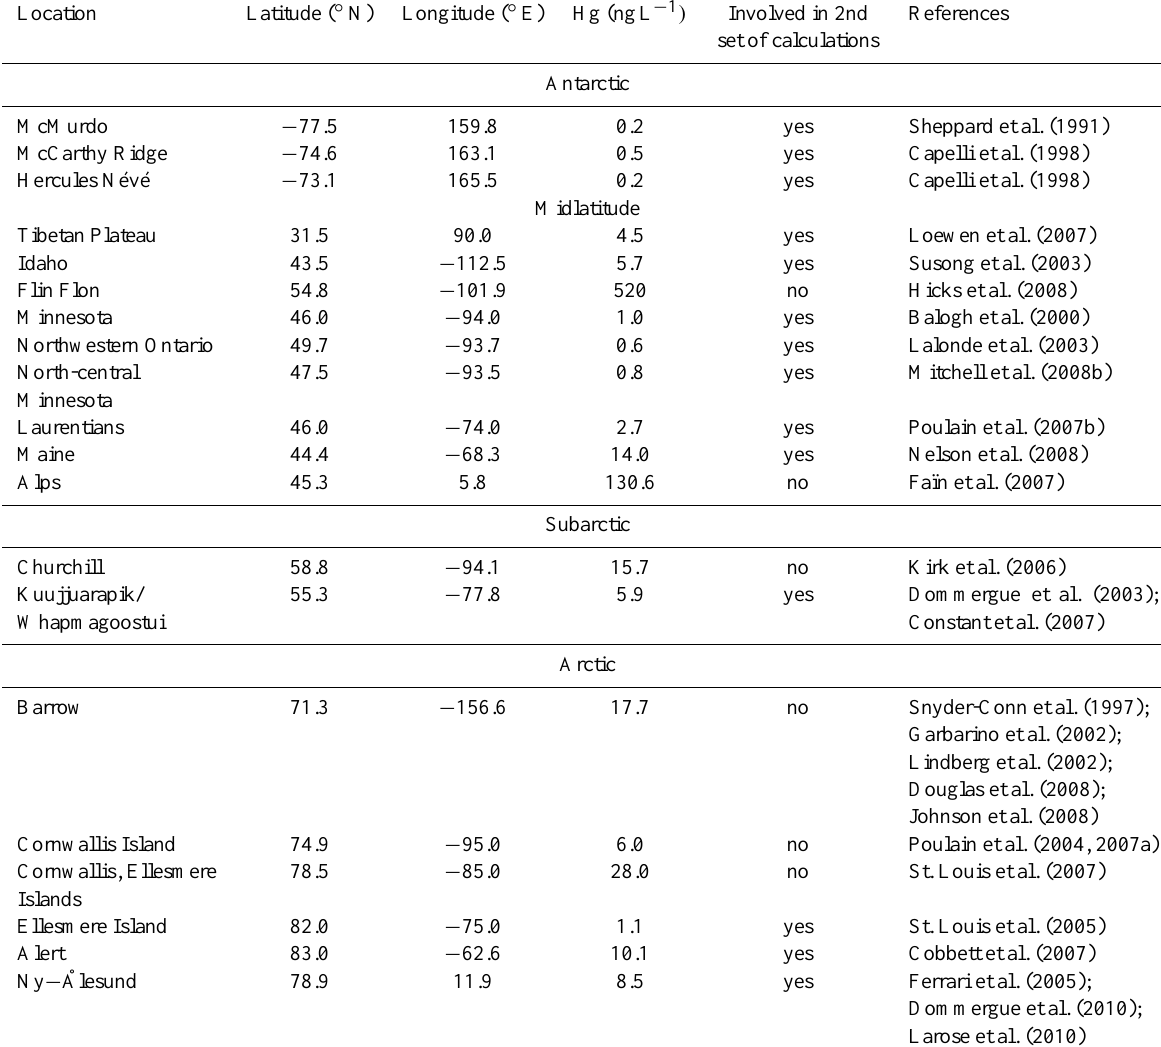
Table 3. Mean concentrations of total mercury in seasonal